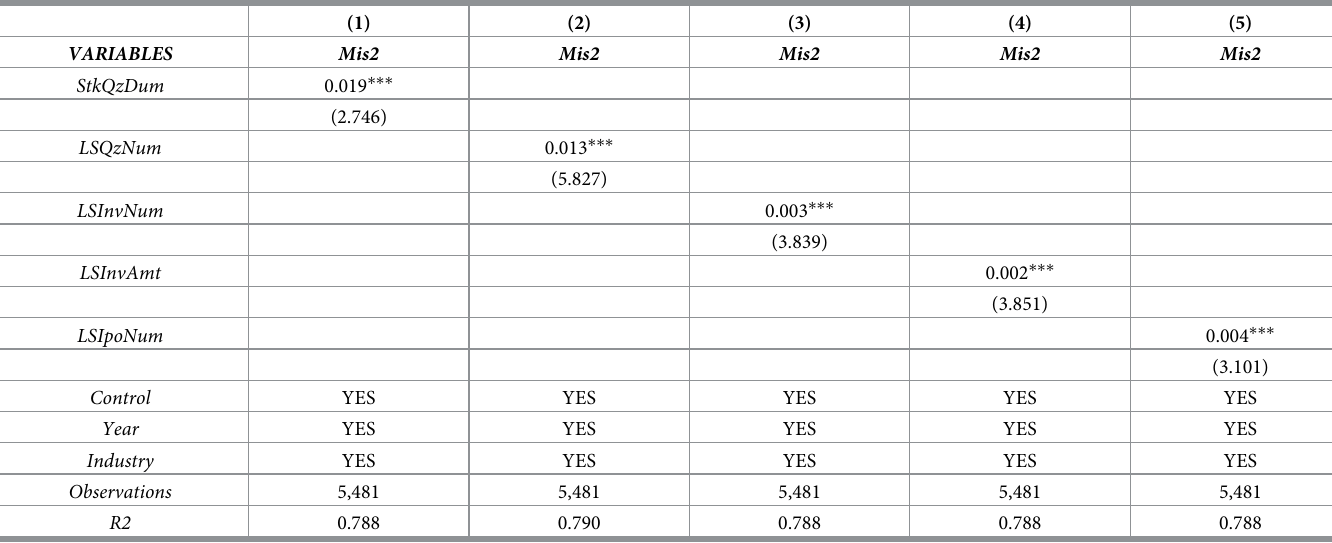
Table 12. VC Quan Zi and asset mispricing (positive)—Alternative